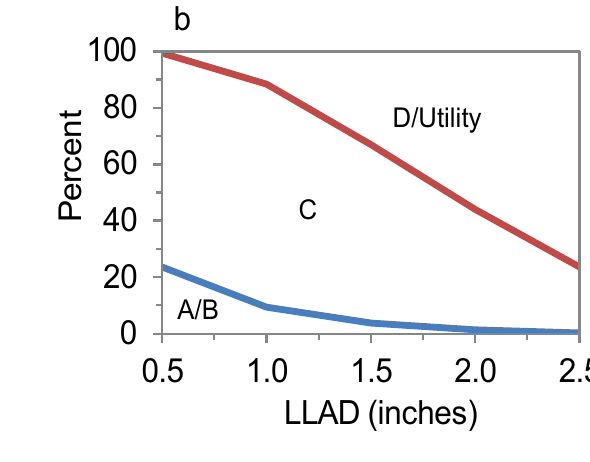
Figure 5. The effect of largest limb average diameter (LLAD) on the percent yield of visual grades of Douglas-fir ( a ) lumber and ( b ) veneer (from